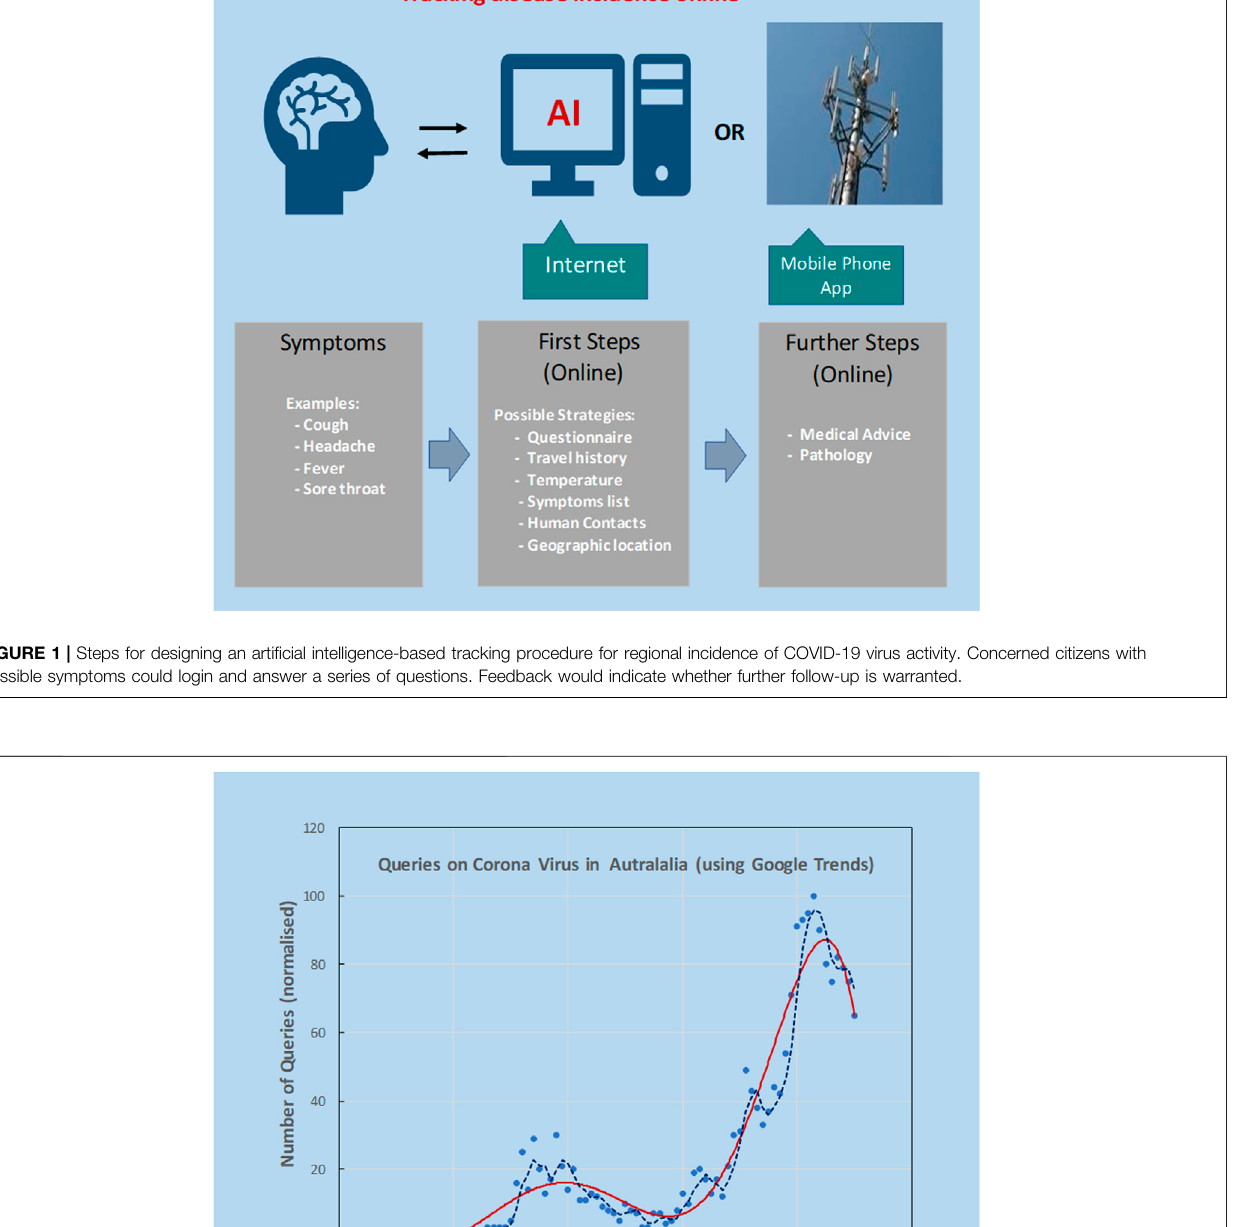
Frontiers in Arti fi cial Intelligence |